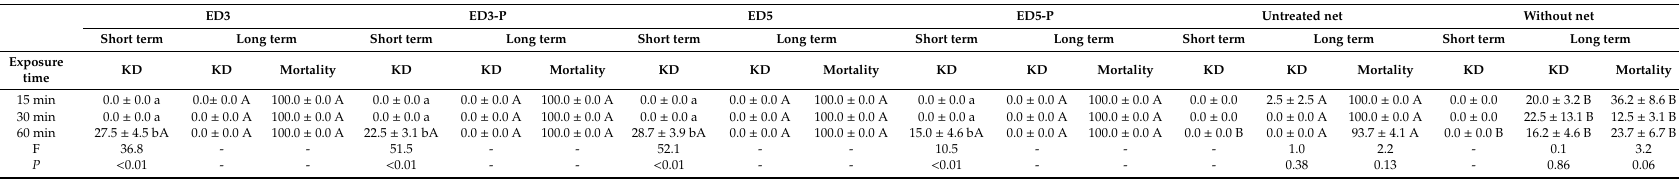
Table 3. Short- and long-term knockdown (KD) and mortality (% ± SE) of Aphis fabae adults exposed for 15, 30, and 60 min to dishes with four di ff erent treated nets (ED3, ED3-P, ED5, ED5-P), dishes with untreated net and dishes without net. The first day after exposure for each exposure interval is considered as the long-term e ff ect. ED3 ED3-P ED5 ED5-P Untreatednet Withoutnet Shortterm Longterm Shortterm Longterm Shortterm Longterm Shortterm Longterm Shortterm Longterm Shortterm Longterm Exposure time KD KD Mortality KD KD Mortality KD KD Mortality KD KD Mortality KD KD Mortality KD KD Mortality